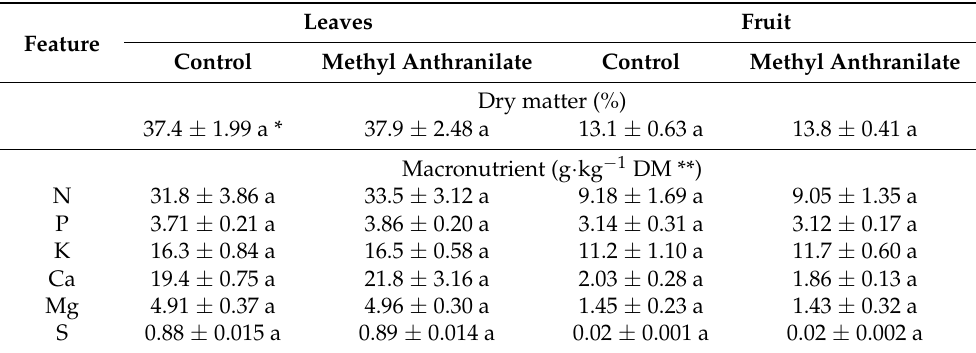
Table 2. The influence of methyl anthranilate on content of dry matter and macronutrients in leaves and fruit of sweet cherry cv.